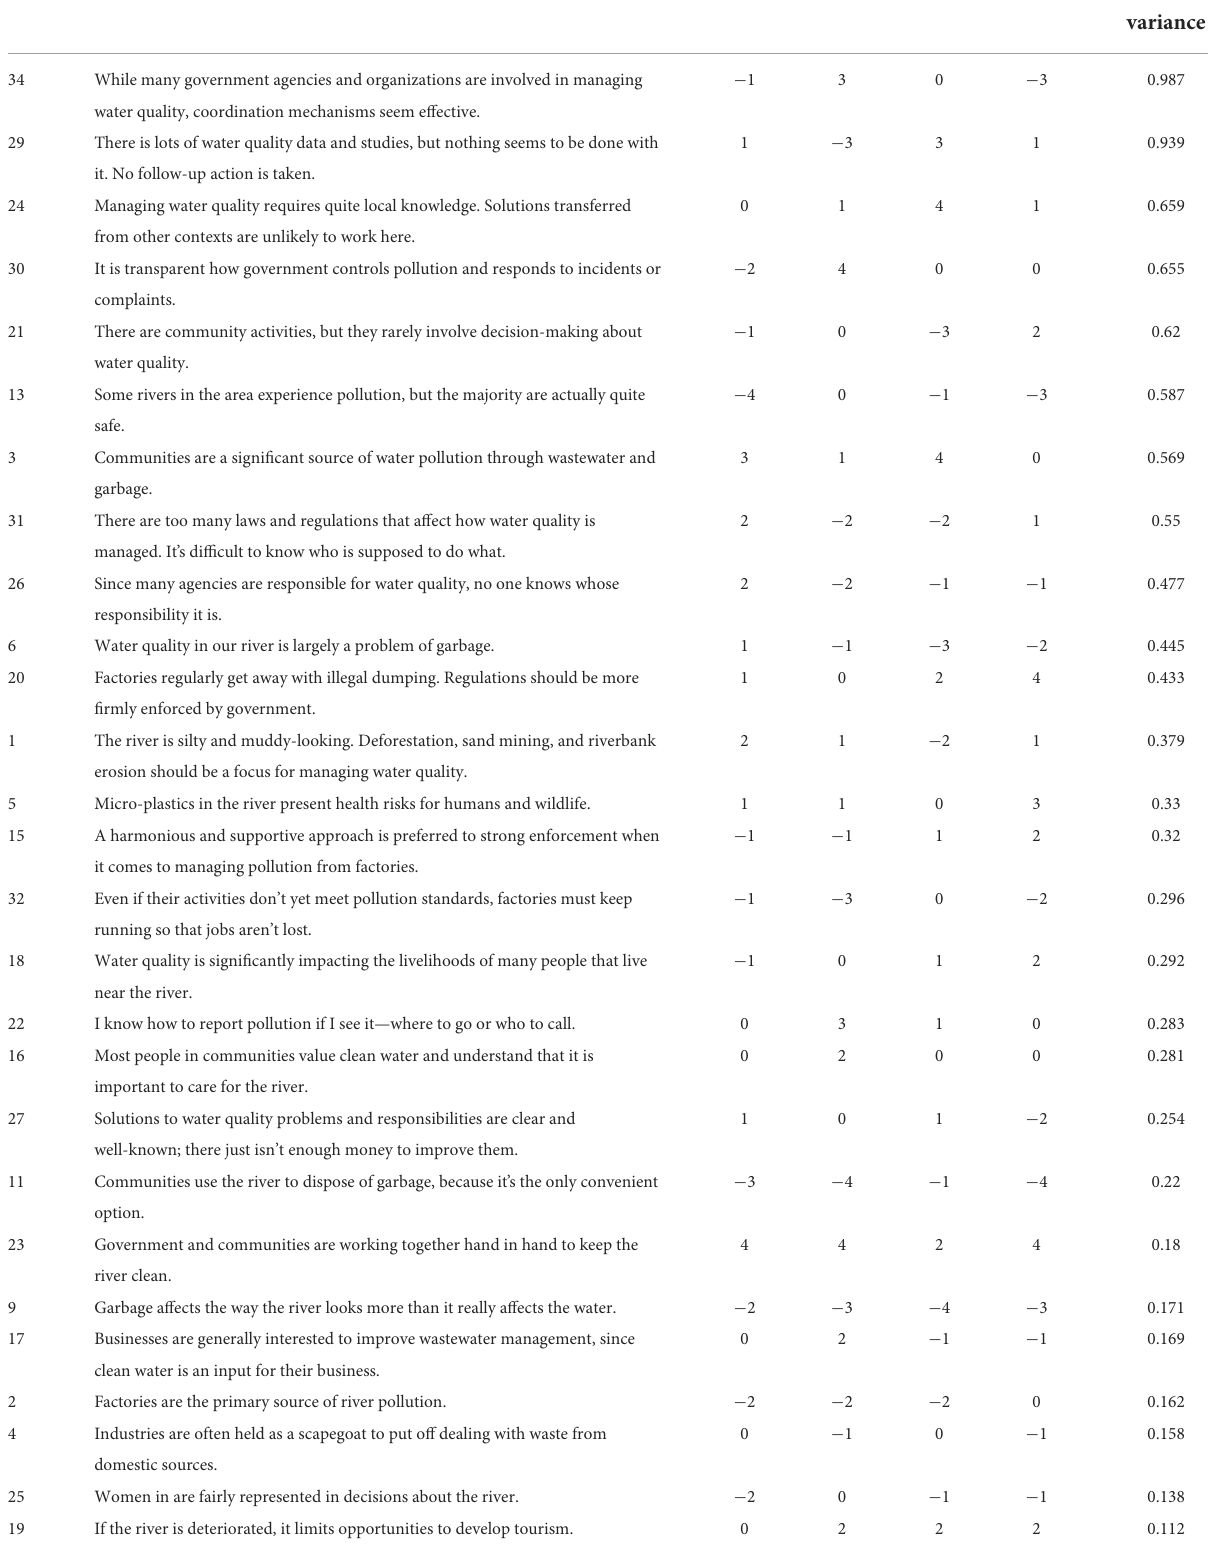
N1 N2 N3 N4 Z -score